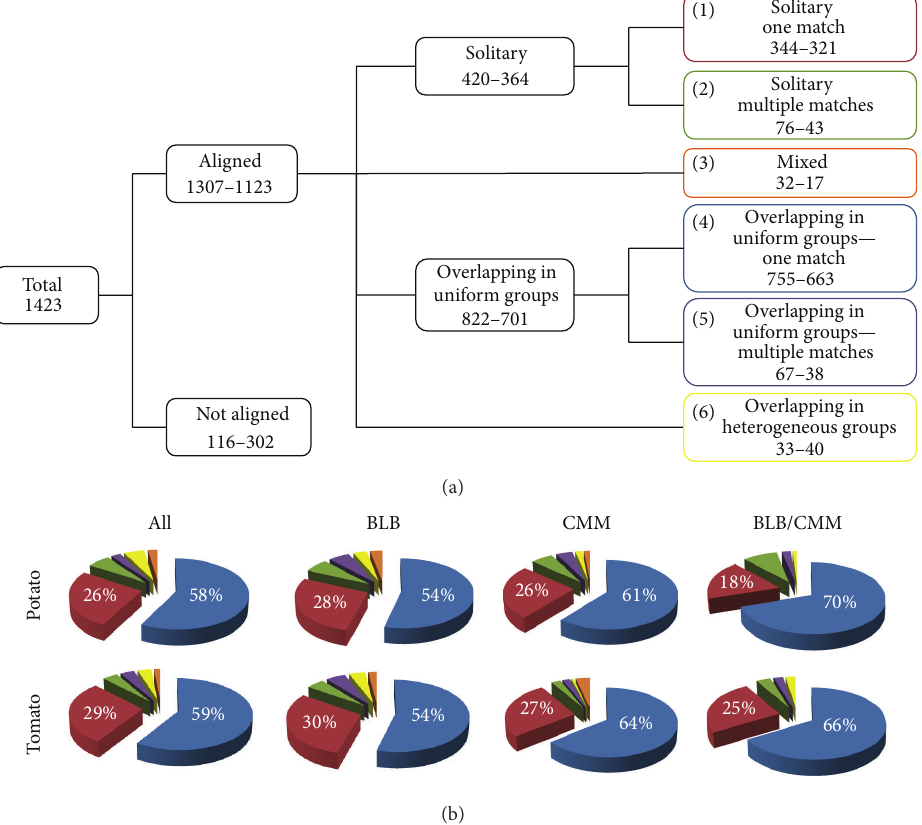
Figure 1: Categories of DArT markers alignments. (a) Values represent the number of alignments along the potato and tomato genome, respectively. (b) Pie charts of the percentage of aligned DArT markers, for each collection. The colour code is associated to the coloured rectangles of (a) and percentages are reported only when greater than 10%.